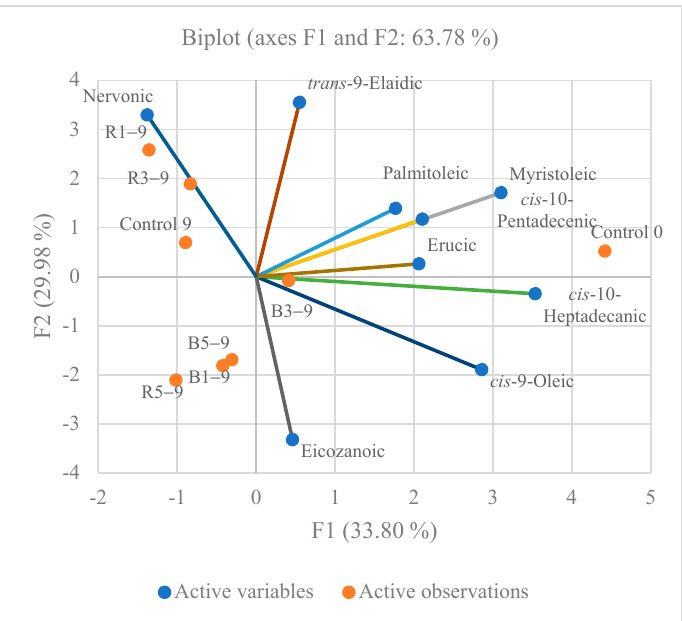
Figure 4. Principal component analysis (PCA) for monounsaturated fatty acids of meat patties with different berries pomace additives stored for nine days (Control 0—meat patties without additives before storage; Control 9—without additives stored for 9 days), R1–9 and B1–9—with 1% of raspberry and blackberry pomace additives after 9 days of storage; R3–9 and B3–9—with 3% of raspberry and blackberry pomace additives after 9 days of storage; R5–9 and B5–9—with 5% of raspberry and blackberry pomace additives after 9 days of storage).